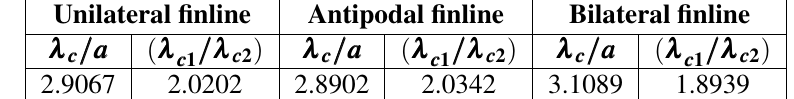
Table 2 The values of the cutoff wavelength ( λ undeformed